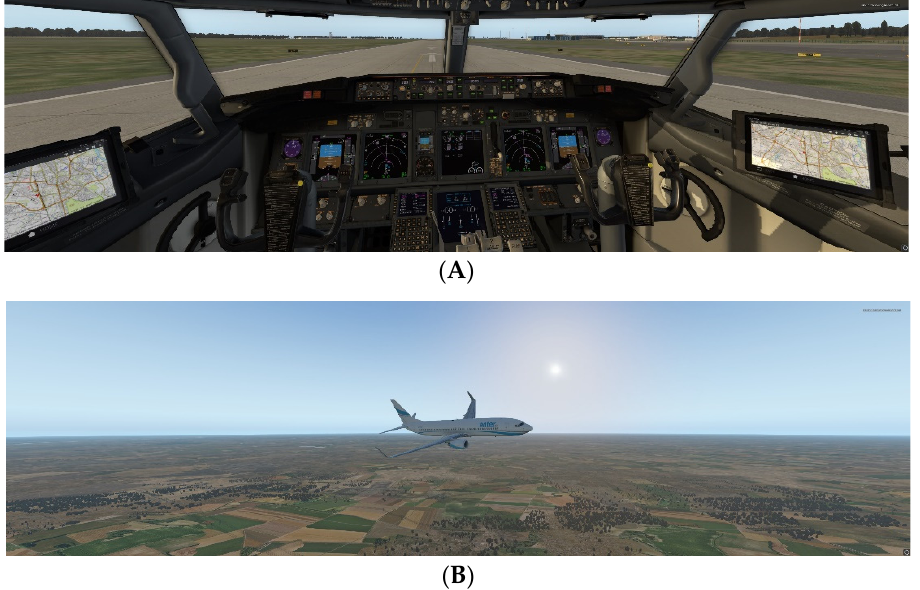
Figure 10. ( A ) External view of a jet airliner—Boeing 737–800—during simulation; ( B ) cockpit view of a jet airliner—Boeing 737–800.